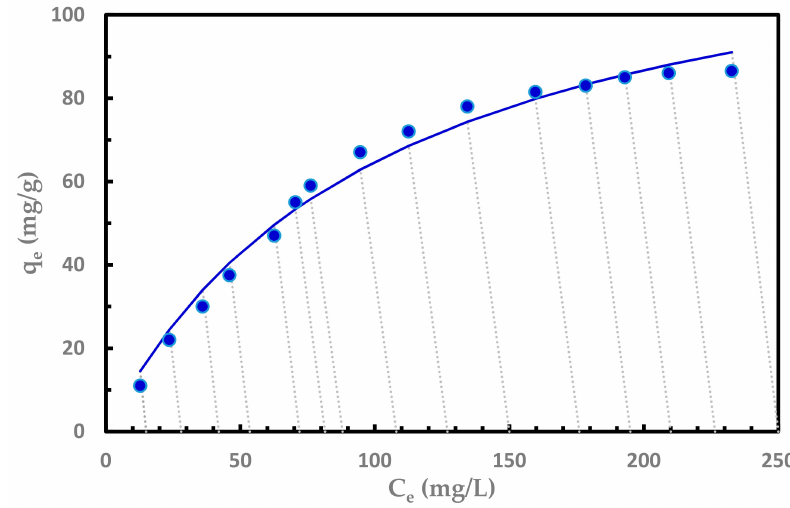
Figure 6. Langmuir isotherm model fitted to the adsorption data of Sr (II) with variable initial concentrations on GO with 10 mg and volume of 50 mL, initial pH 5, and 25 ◦